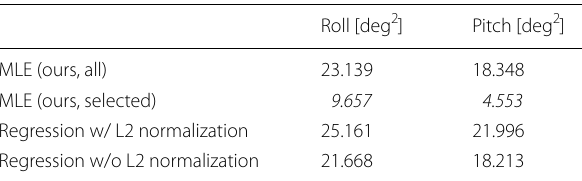
Table 6 Variance of estimated attitude error in known environment (#2)